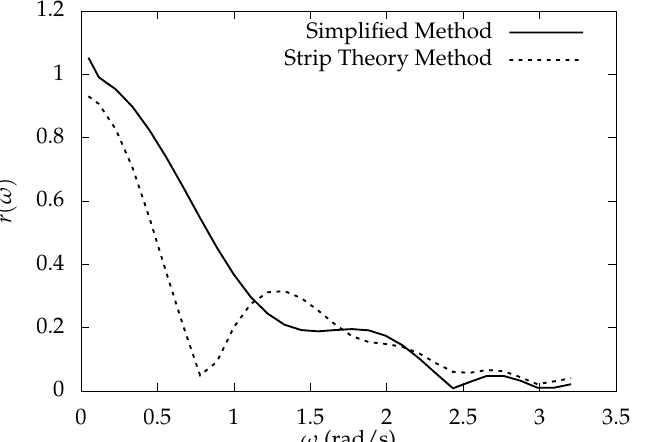
Figure 6. Effective wave slope function computed using simplified “formal” method and strip theory “direct” method for a simple barge